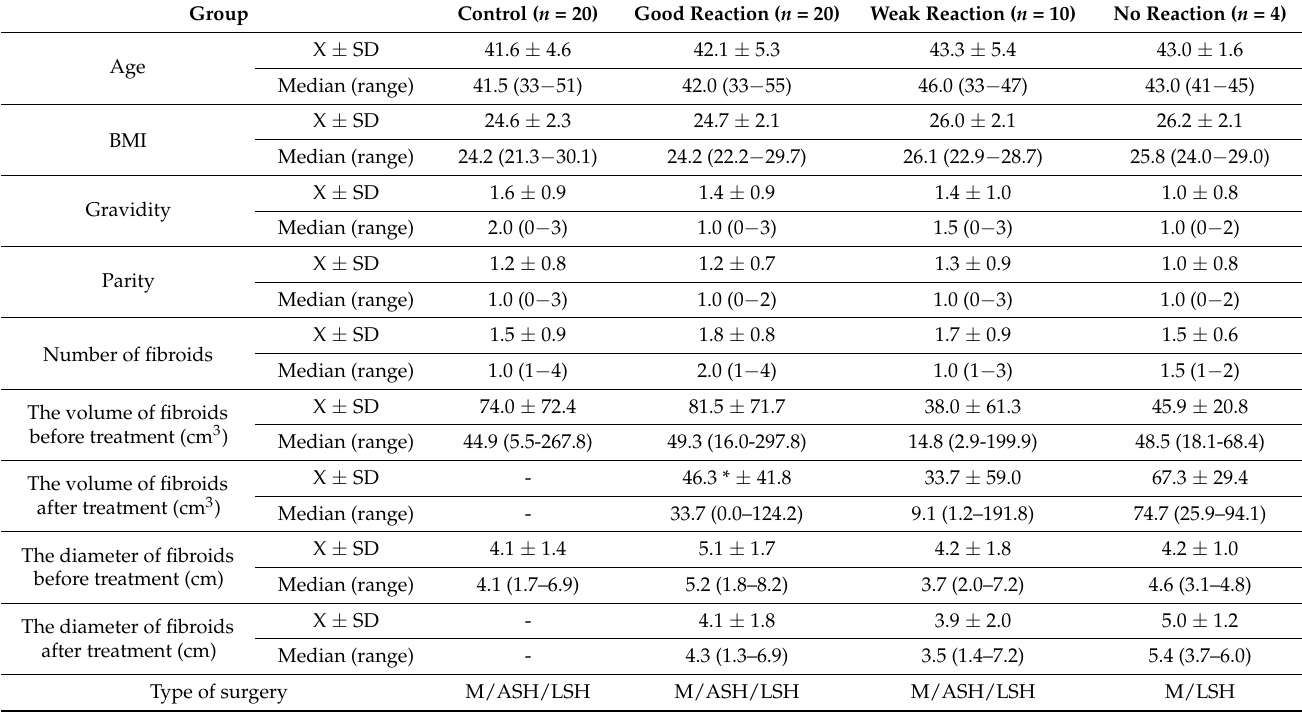
Table 1. Baseline characteristics of the